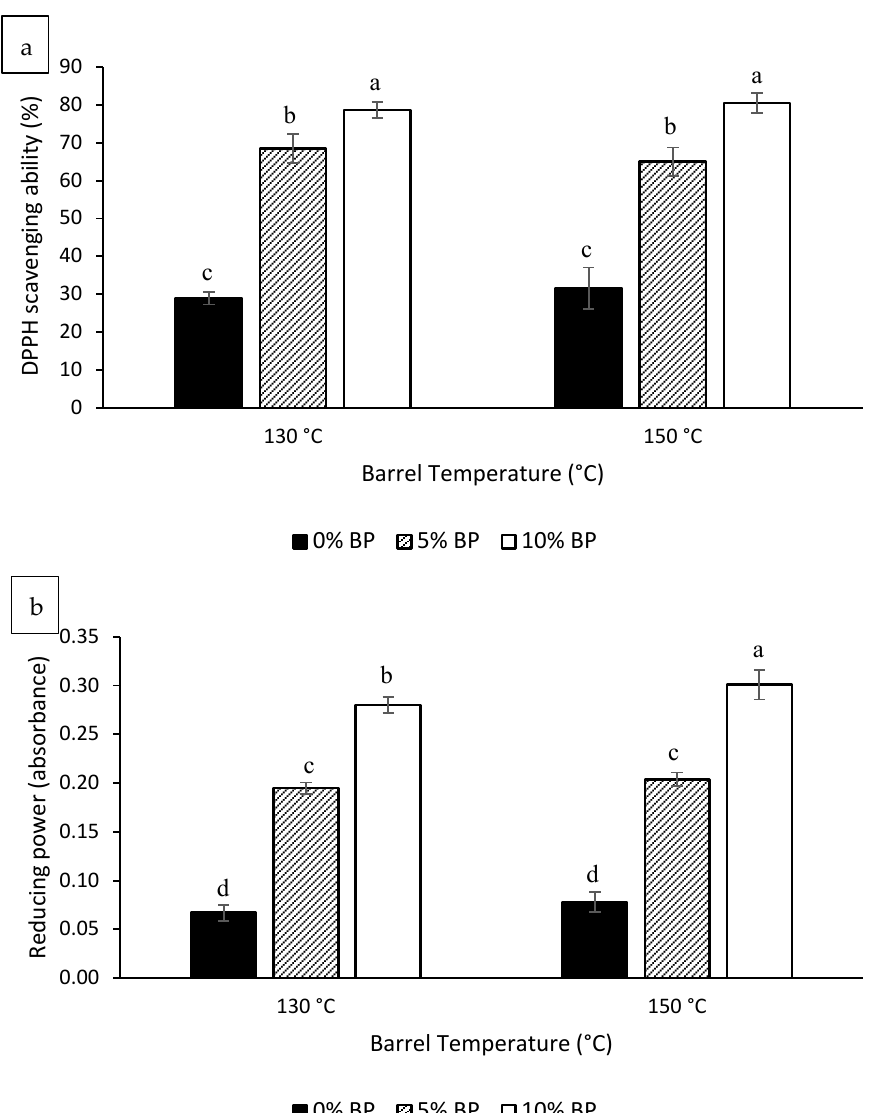
Figure 2. DPPH (1,1-diphenly-2-picryl-hydrazil) scavenging ability ( a ) and reducing power ( b ) (mean ± standard deviation) of extrudates as a function of extrusion die temperature and butterfly pea flower (BP) concentration. Bars assigned with same letters are not significantly ( p < 0.05) different ( n = 2 for extrusion, n = 3 for total DPPH scavenging ability and reducing power).